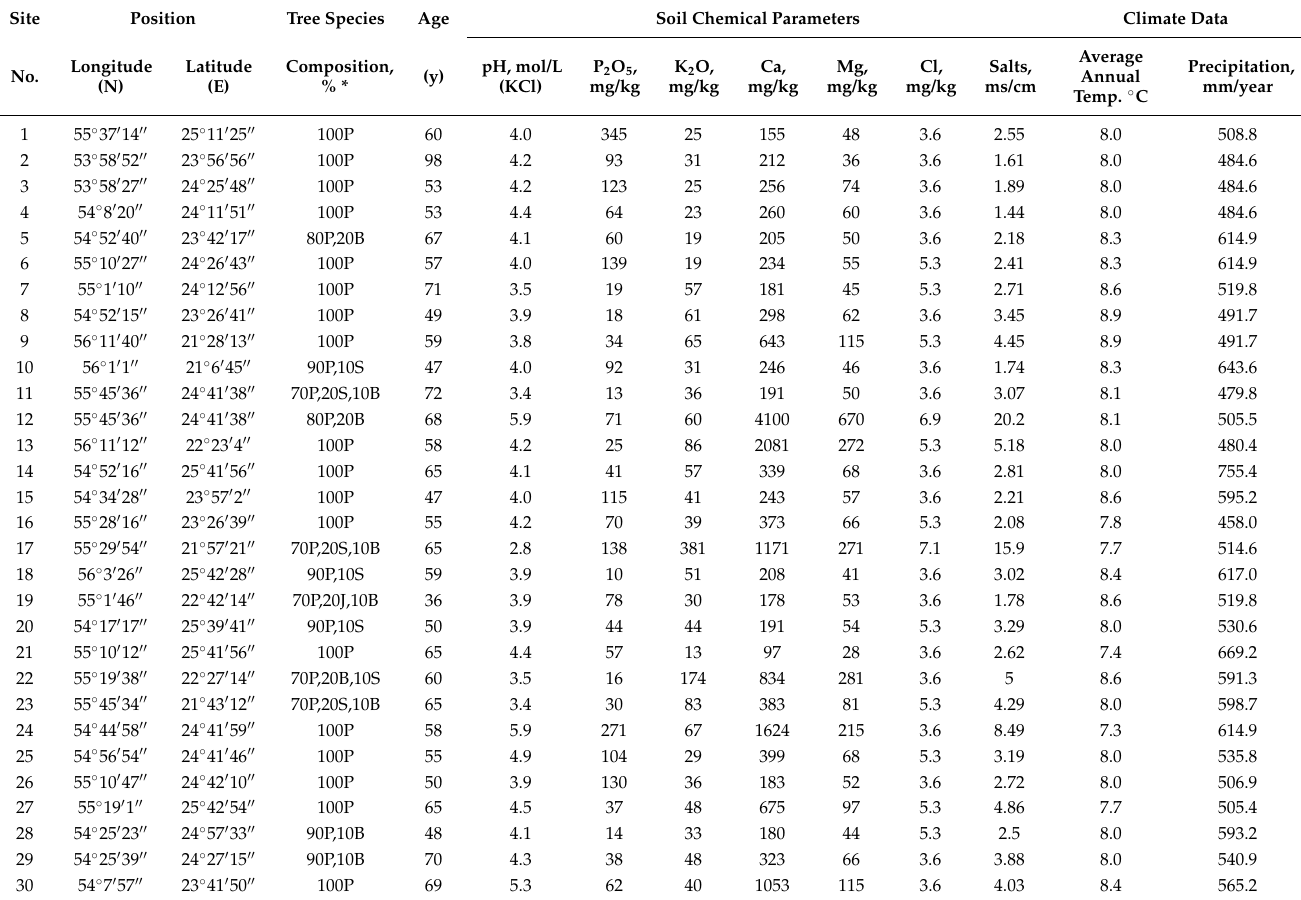
Table 1. Principal information on the 30 sampling sites in Pinus sylvestris forest